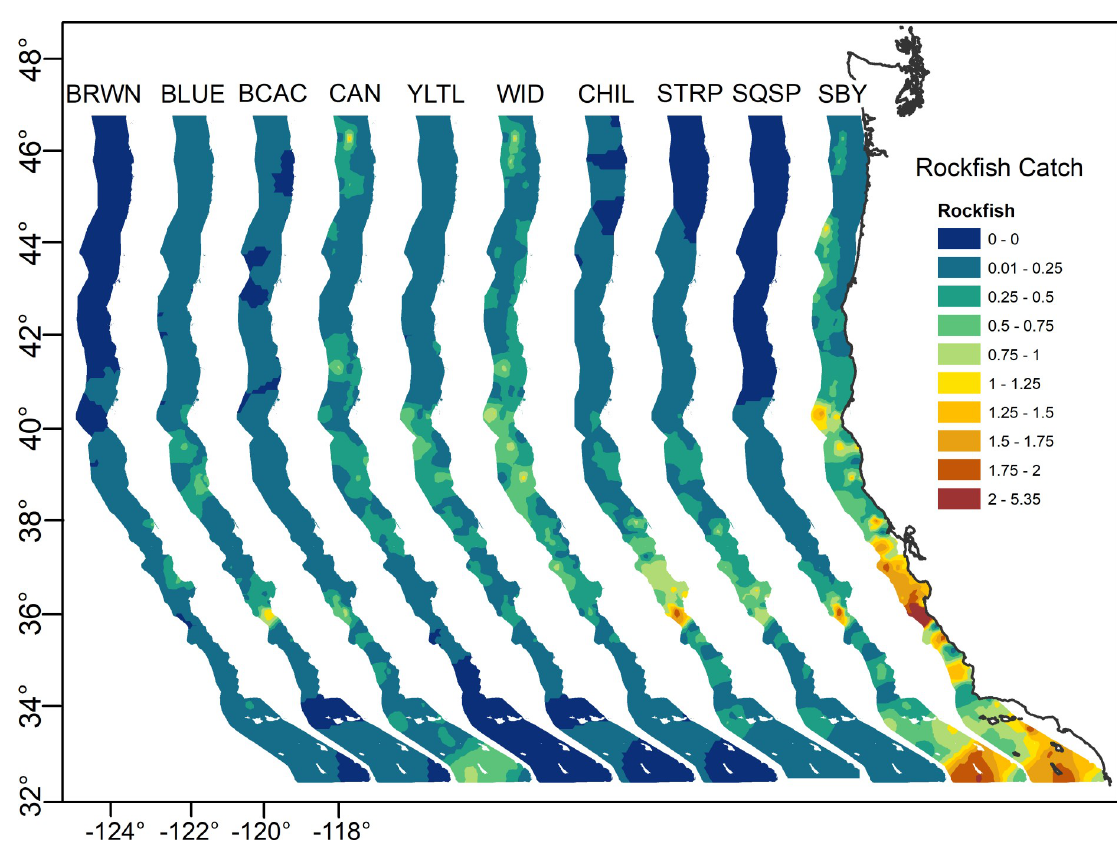
Fig 2. Mean log transformed CPUE of YOY rockfish by species (and for all species, “All Rf”) for all climatology years (2004–2009, 2013–2019). Common names as follows, BRWN = Brown, BLUE = Blue/Deacon, BCAC = Bocaccio, CAN = Canary, YLTL = Yellowtail, WID = Widow, CHIL = Chilipepper, STRP = Stripetail, SQSP = Squarespot, SBY = Shortbelly.